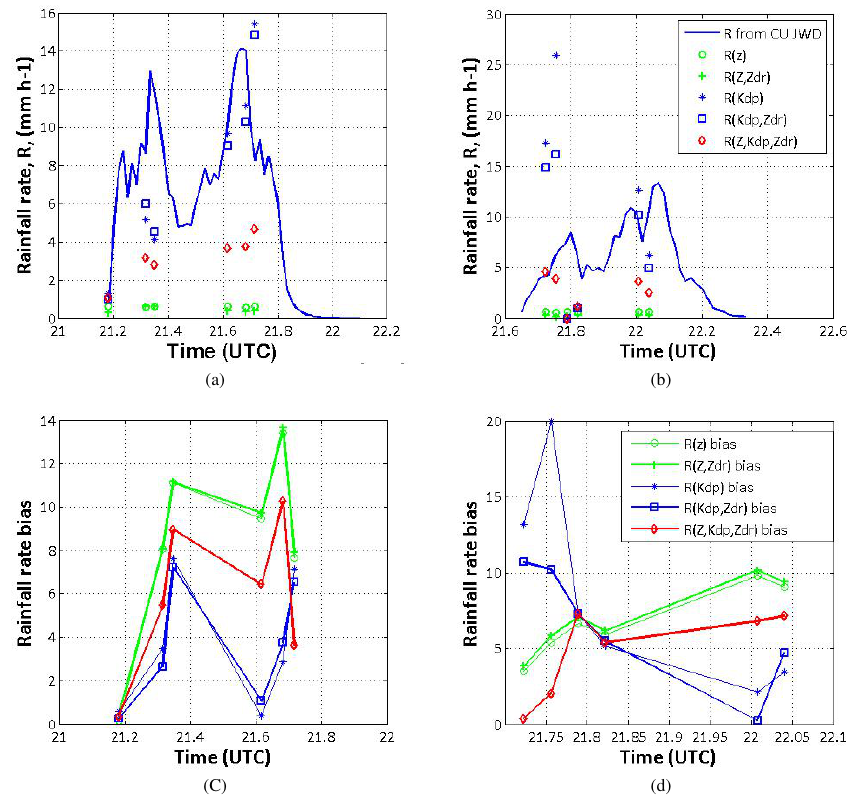
Figure 6. Rain rates for light to moderate rainfalls over (a) BAO and (b) PLT on 17 June 2004 and respectively their corresponding rainfall rate bias (c) for BAO and (d) for PLT.